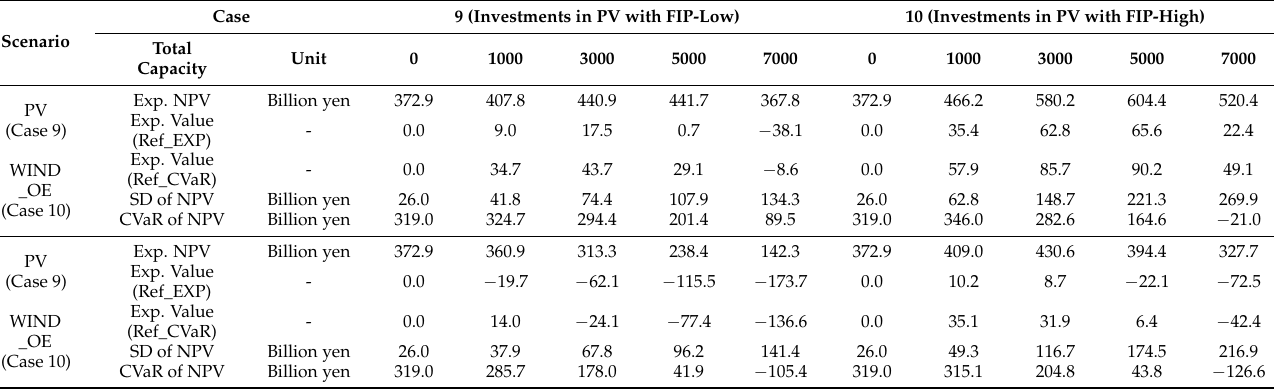
Table A6. Calculation results of Cases 9 and 10 (corresponding to Figure